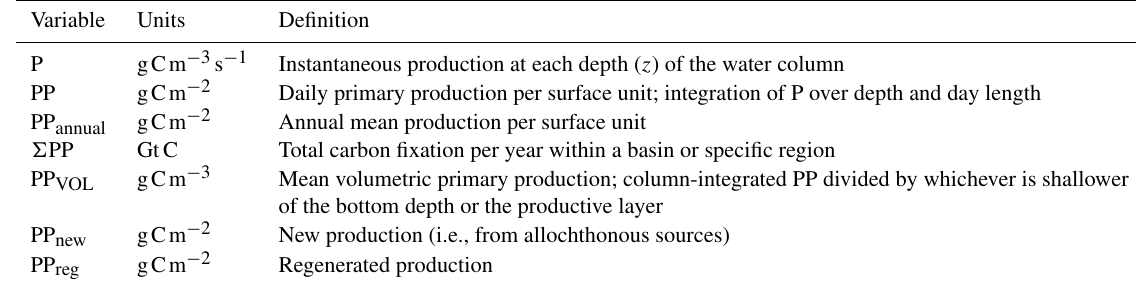
Table 1. Primary production acronyms used in this study, their units, and their definitions. Variable